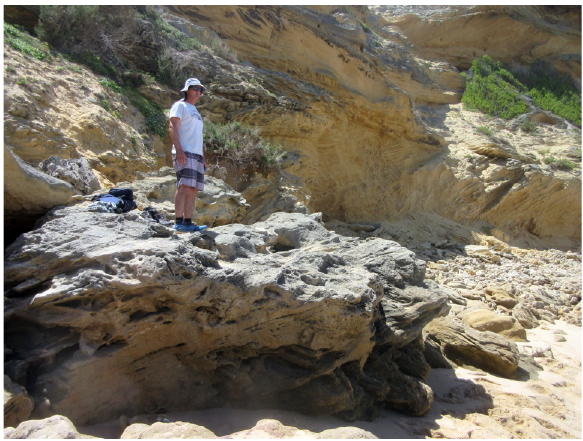
Figure 6: Megafauna Rock.